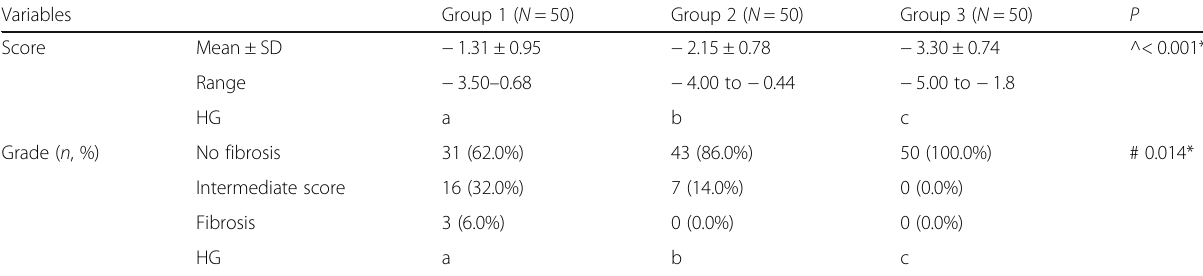
Table 2 NAFLD fibrosis score among the studied groups